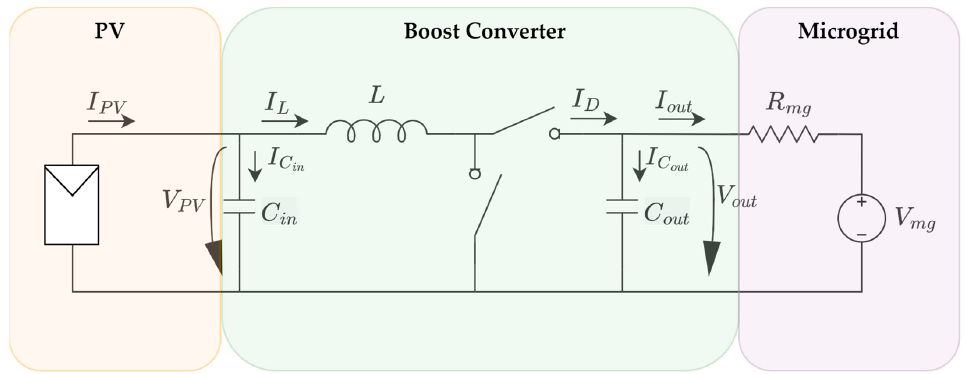
Figure 11. HIL implementation diagram.